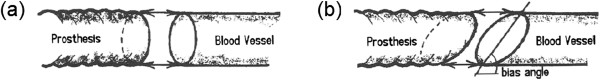
Geometric compliance matching. The graft constructed with an elliptic cross-section (b) develops peak stresses that are orders of magnitude lower than those developed with conventional ETE configurations (a). Circular grafts and vessels cut on a bias (bevelled end) provide an increased anastomotic junction perimeter which can reduce stress concentrations by distributing the loading force among a potentially greater number of sutures. The introduction of matching geometric compliance that dominates at the anastomotic junction minimizes the consequences of material mismatch between graft and vessel and has the potential to reduce the suture line stress (taken from [71] with permission).